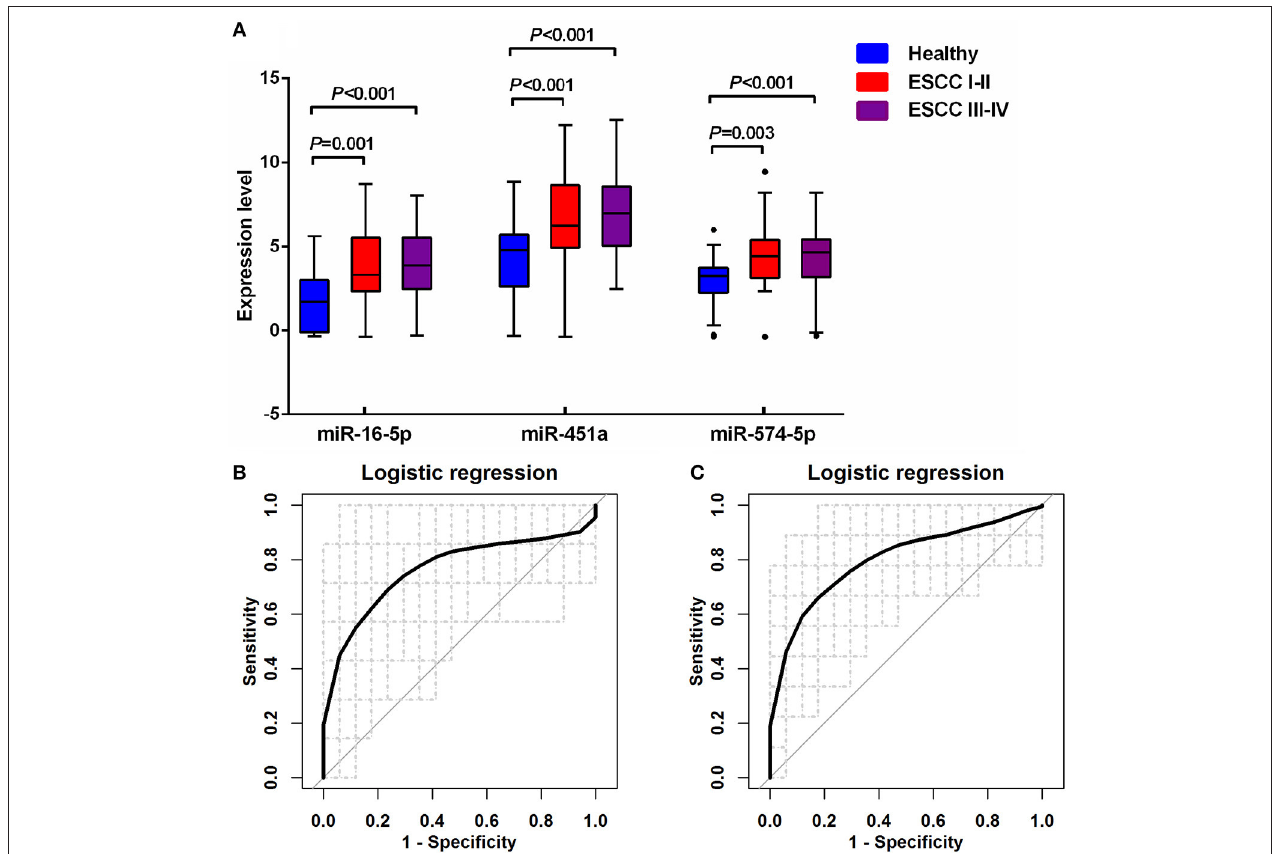
FIGURE 5 | Quantification of serum miR-16-5p, miR-451a, and miR-574-5p in the healthy controls and two different ESCC groups. (A) The box plot comparing the expression level of serum miR-16-5p, miR-451a, and miR-574-5p in the healthy control with ESCC patients with stage I-II (ESCC I-II) and with stage III-IV (ESCC III-IV). (B) The ROC curve for the three serum miRNA-based panel in differentiating ESCC I-II from the healthy by logistic regression. (C) The ROC curve for the three serum miRNA-based panel in differentiating ESCC III-IV from the healthy by logistic regression.